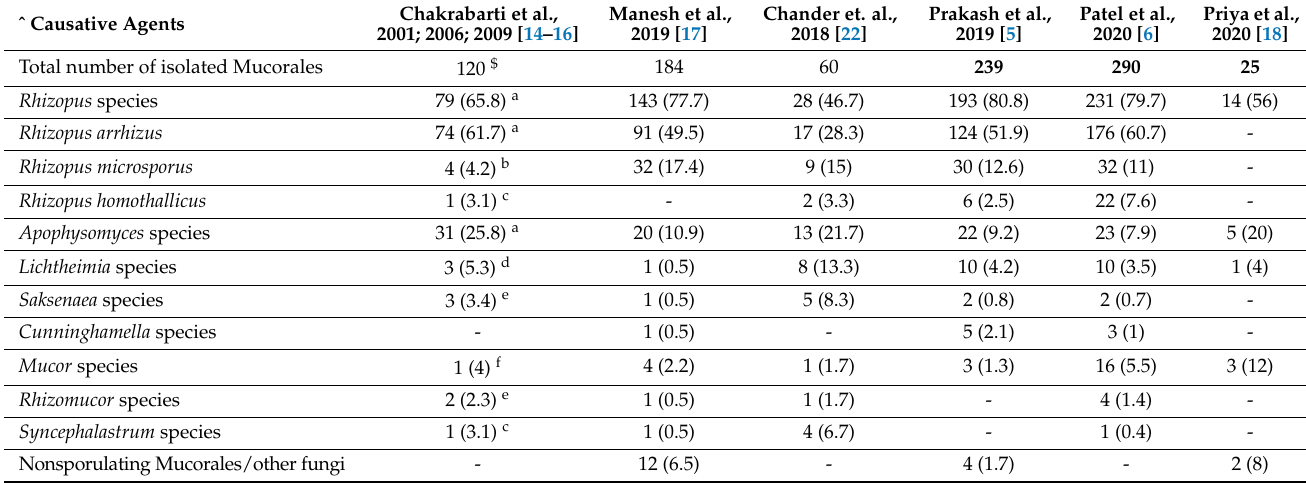
Table 2. Causative agents of mucormycosis in India.